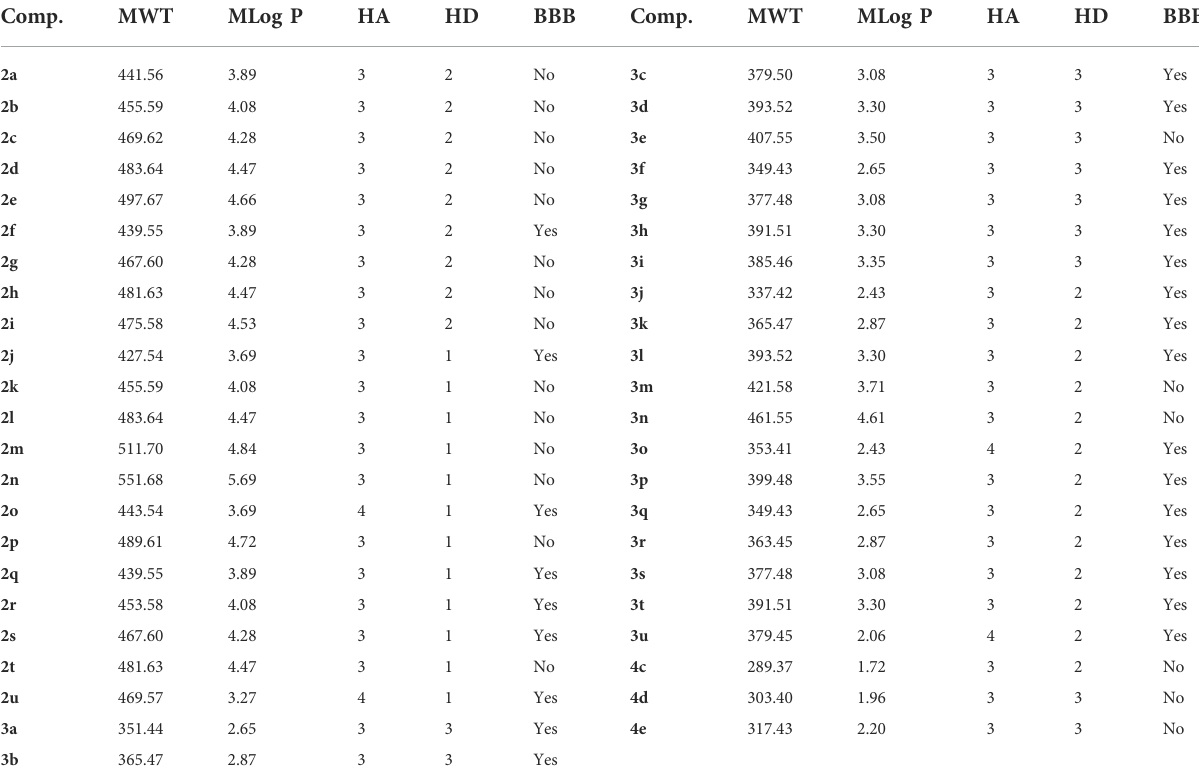
TABLE 5 The predicted druggability of synthesized compounds.